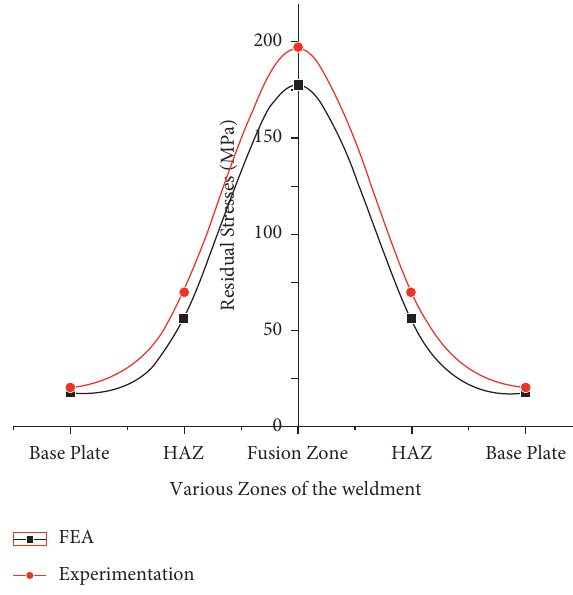
Figure 14: Comparison of residual